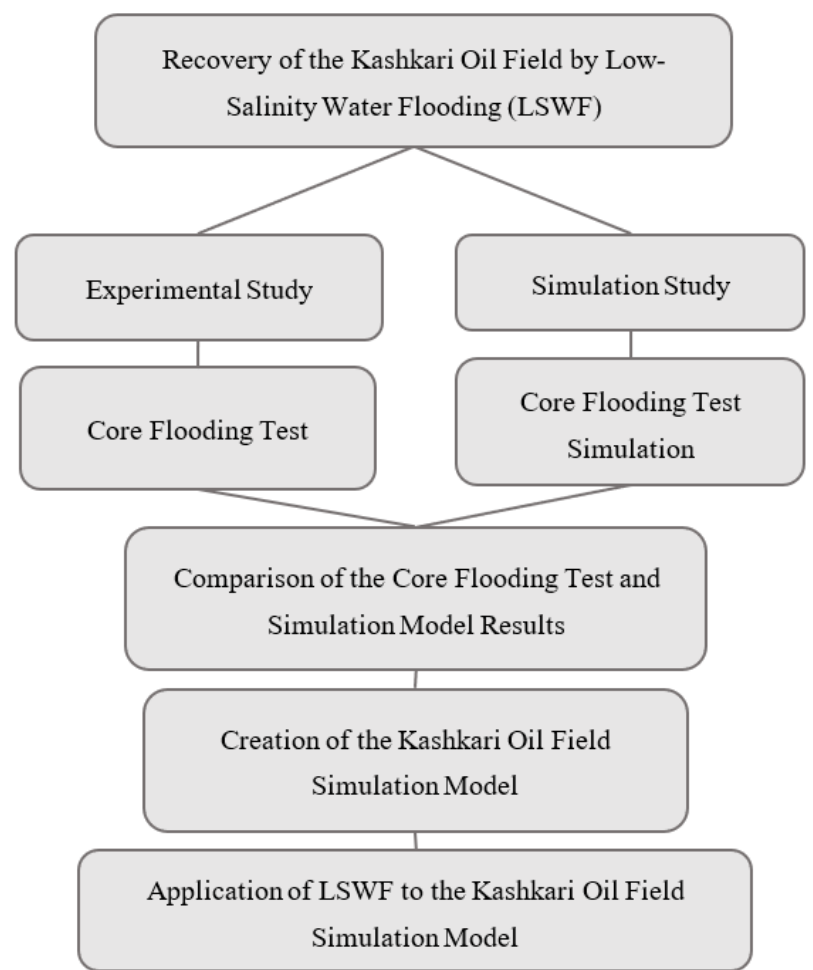
Figure 1. Diagram of Kashkari oil field recovery by LSWF.